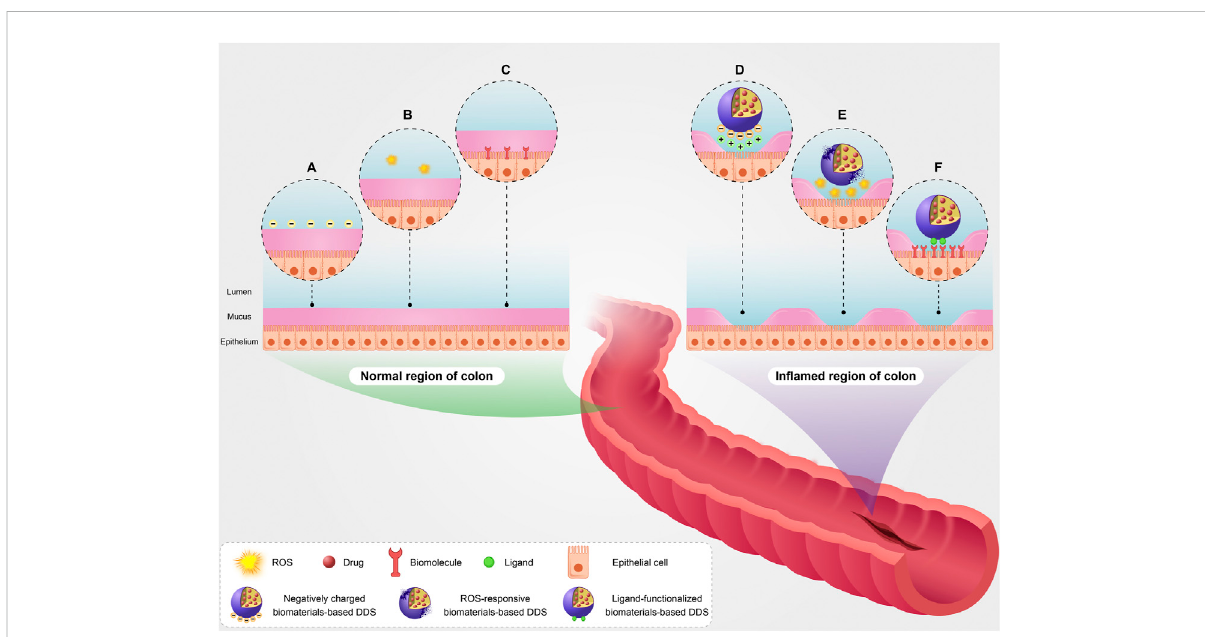
FIGURE 1 Aschematicillustrationoftargetingpathophysiologicalchangesusingbiomaterials-baseddrugdeliverysystem(biomaterials-basedDDS)inthe colon of patients with IBD. Surface charge of epithelium (A) , basic ROS level (B) , and basic expression level of some biomolecules such as in fl ammatory biomarkers (C) in the normal region of colon. Targeting pathophysiological changes including positive surface charge of injured epithelium using negatively charged biomaterials-based DDS (D) , high ROS level using ROS-responsive biomaterials-based DDS (E) , and overexpression of the biomolecules using ligand-functionalized biomaterials-based DDS (F) in the in fl amed region of